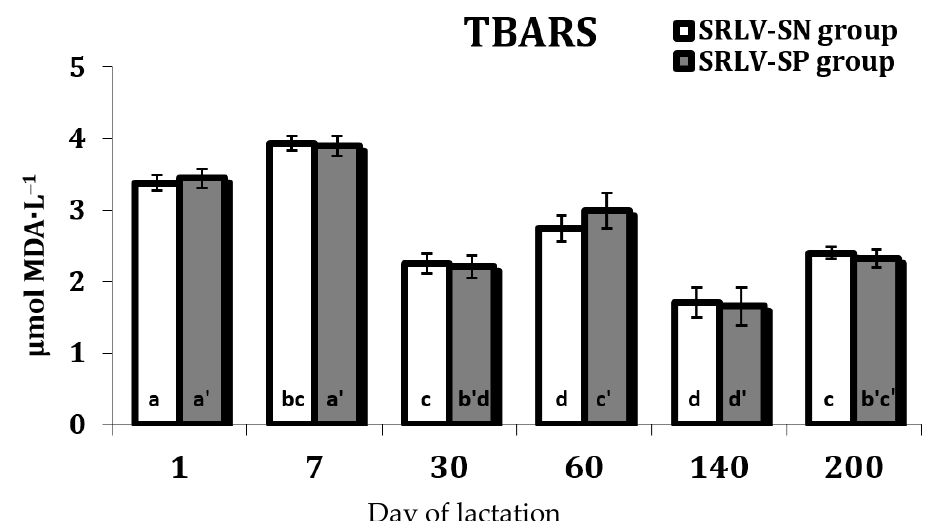
Figure 1. Lipid peroxidation, estimated by TBARS content ( µ mol MDA · L − 1 ) in the serum of SRLV-SN and SRLV-SP goats during lactation. Values are expressed as means ± SEM; a, b, c, d—different letters indicate significant differences between stages of lactation within the SRLV-SN group at p < 0.05; a’, b’, c’, d’—different letters indicate significant differences between stages of lactation within the SRLV-SP group at p < 0.05; SRLV-SP—small ruminant lentivirus seropositive goats; SRLV-SN—small ruminant lentivirus seronegative goats.